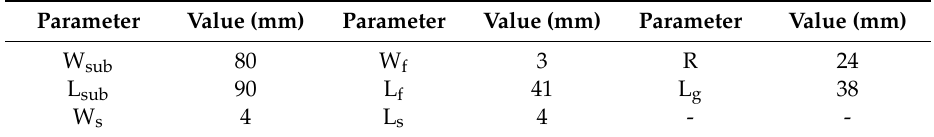
Figure 1. Layout of the original ultrawideband (UWB) antenna: ( a ) top view; ( b ) bottom view. Table 1. Antenna parameters and their values.